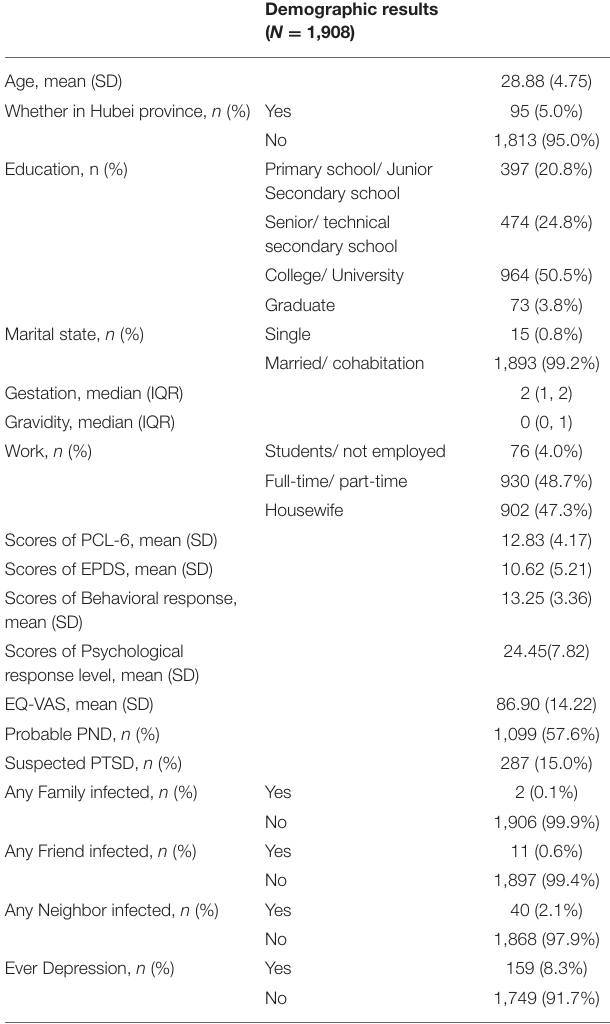
TABLE 1 | Descriptive statistics of the demographic